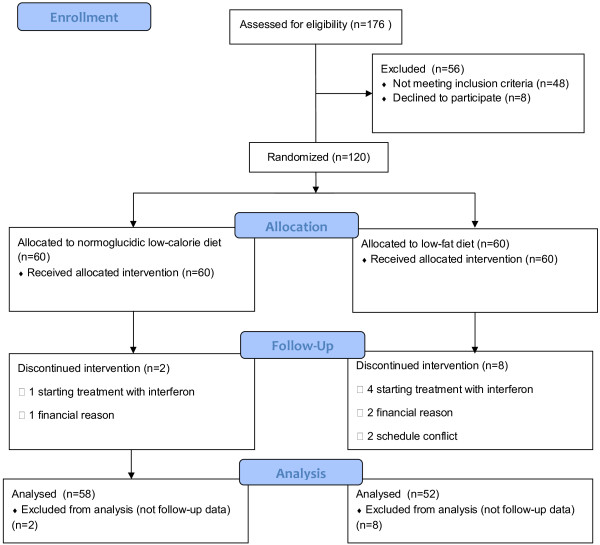
Participant flow diagram.